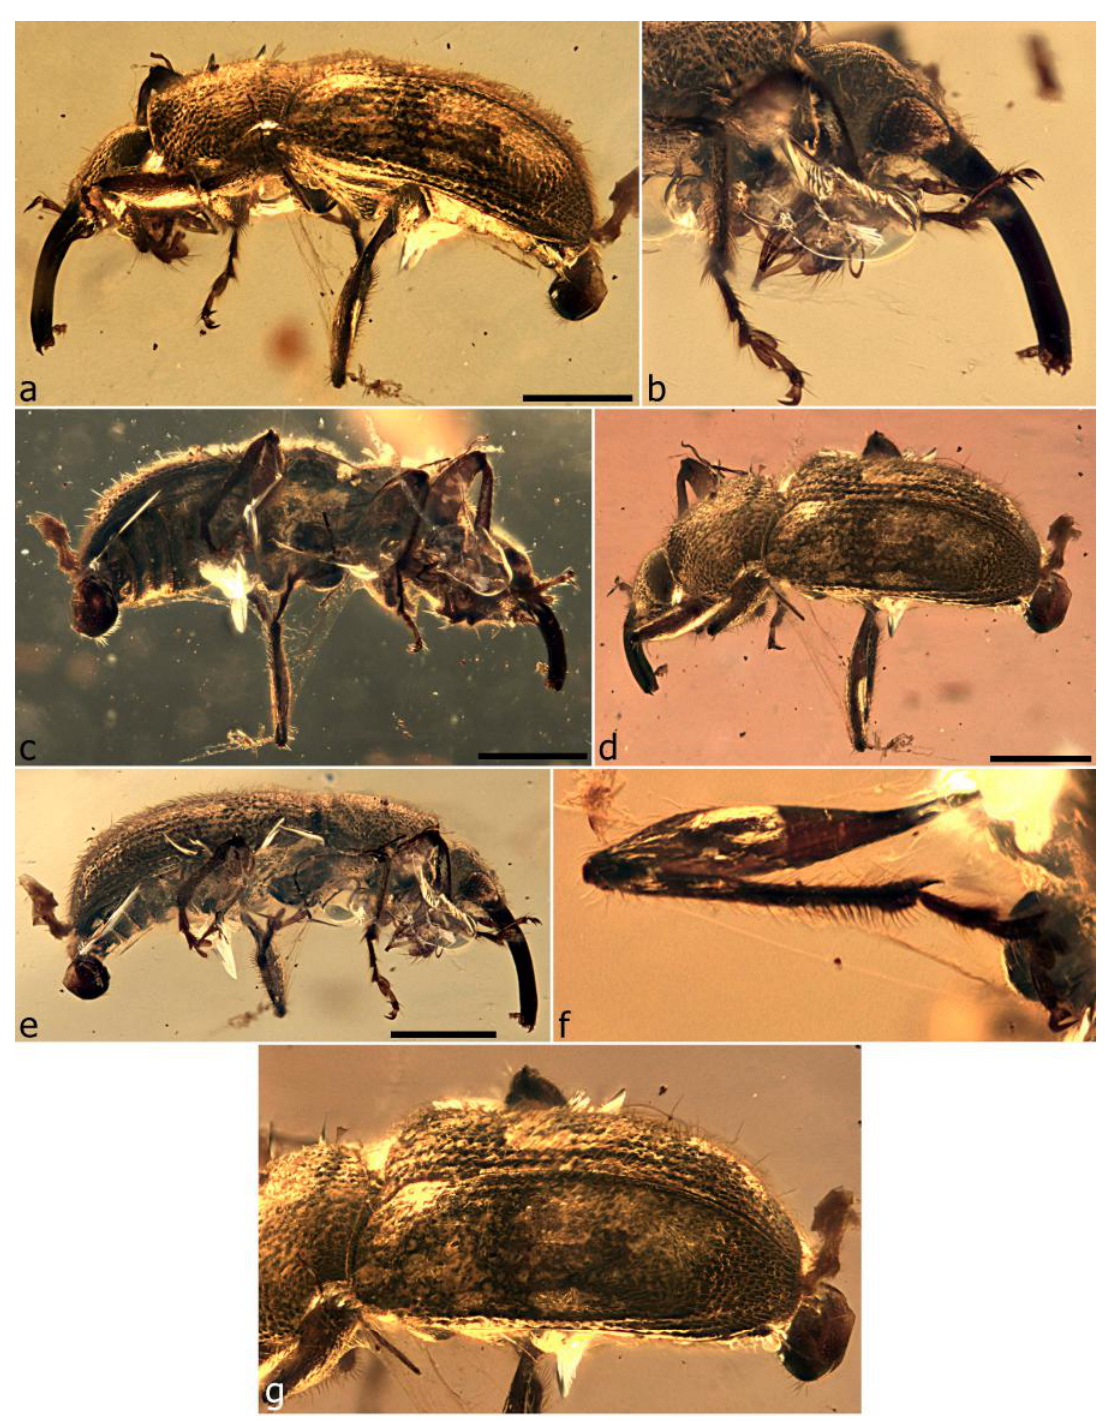
Figure 27. Acalyptopygus elongatus sp. n., holotype. Habitus, left lateral ( a ); head and anterior leg, left ( b ); habitus, right ventrolateral ( c ); habitus, left dorsolateral ( d ); habitus, right lateral ( e ); hindleg, ventral ( f ); pronotum and elytra ( g ). Scale bars: 0.5 mm (a,c–e).